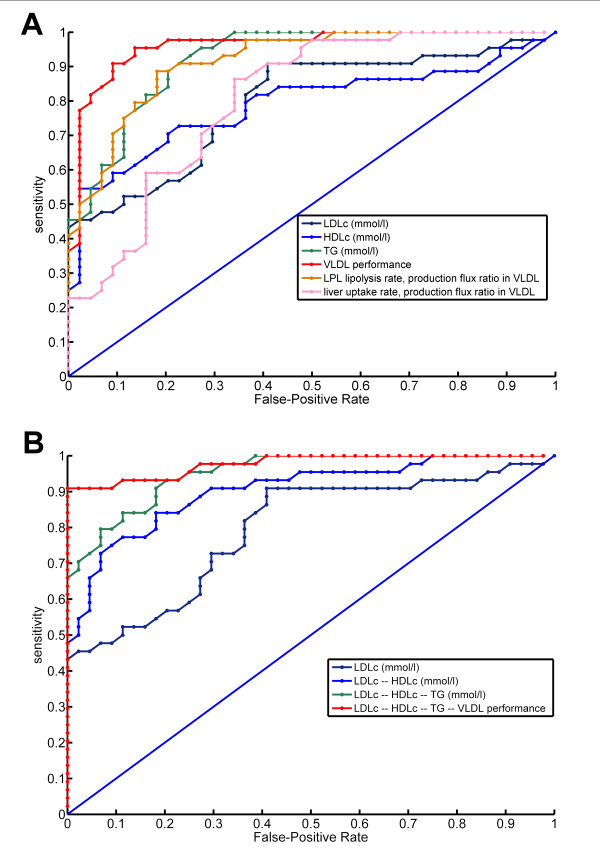
Receiver operating characteristic (ROC) curves for dyslipidemia. These curves indicate how well a) single diagnostics and b) multivariate regression models distinguish dyslipidemic subjects from normolipidemic subjects. The models in b) subsequently include LDLc, HDLc, TG, and VLDL performance in cumulative fashion. The ROC curve indicates with what sensitivity various diagnostics can identify dyslipidemic subjects, when varying the acceptable false-positive rate. An ROC curve further away from the 1-1 identity line indicates a better diagnostic. For example, when not accepting false positives, the regression model including LDLc, HDLc and TG has a sensitivity of 66% (0.66), while additionally including the VLDL performance diagnostic results in a sensitivity of 91% (0.91).